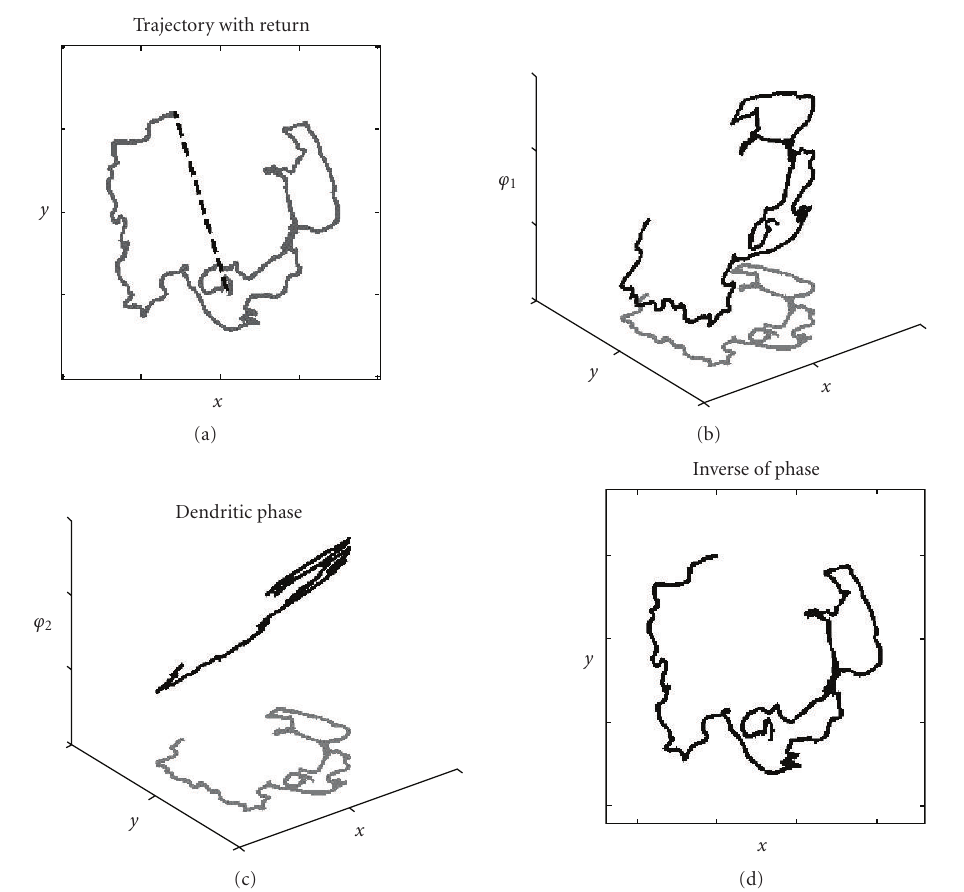
Figure 3: Coding of location by phase. (a) Actual trajectory run by the rat is shown in gray. If phase is reset at start location, the inverse transform of phase at any position yields a return vector with angle and distance leading back to start (shown with black dashed line). (b) Plot of membrane potential oscillation phase ϕ in a single dendrite of a simulated grid cell, showing linear change in phase with one dimension of location (dendrite receives input from head direction cell with angle preference zero). (c) Phase of another dendrite receiving input from head direction with angle preference 120. (d) Performing the inverse transform of oscillation phases at each point in time e ff ectively reconstructs the full